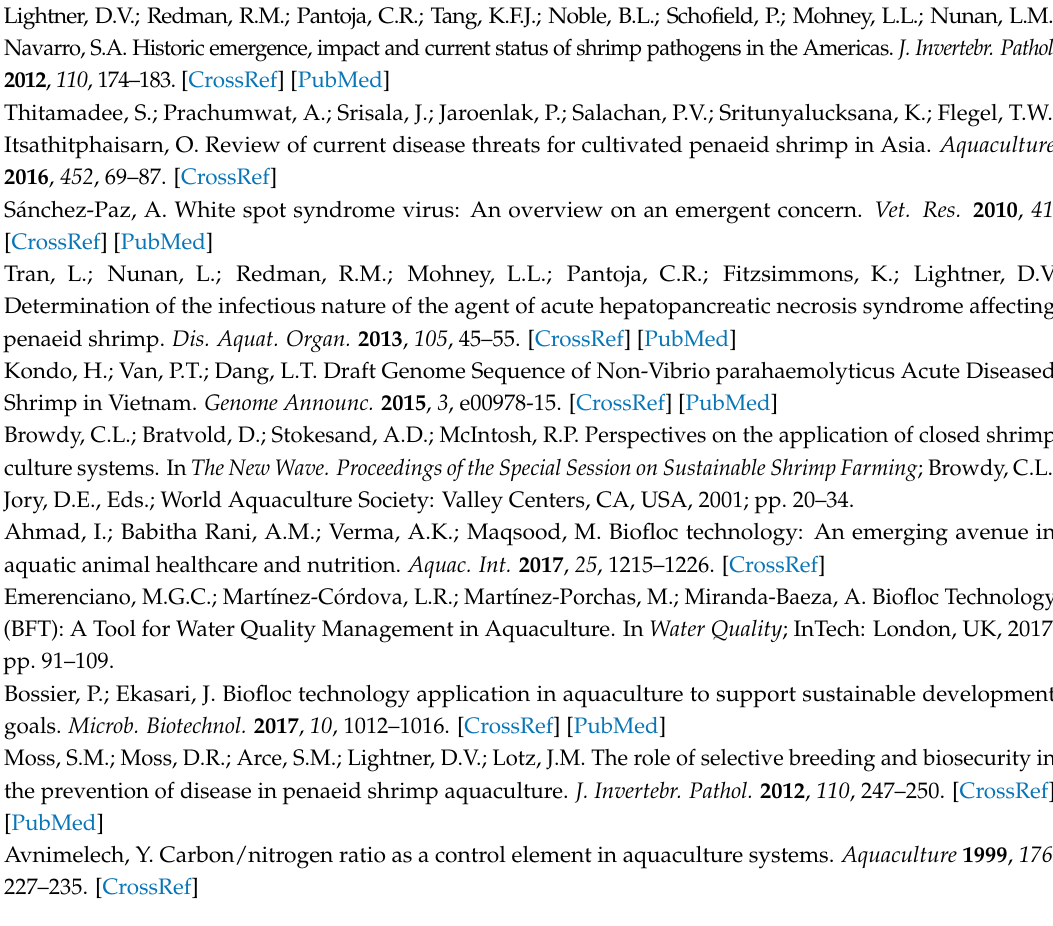
Table S1: Physicochemical parameters of the BFT water after four months of Litopenaeus vannamei rearing, Table S2: Overview of 16S-based Illumina Hi-Seq 2500 sequencing of Litopenaeus vannamei midgut reared in bioflocs (BFT) and clear seawater (CWS) and challenged with WSSV (BFT.W and CWS.W), Table S3: Shared and unique OTUs annotation from Litopenaeus vannamei midgut reared in bioflocs (BFT) and clear seawater (CWS) and challenged with WSSV (BFT.W and CWS.W), and the abundance of unique OTUs annotation from major bacterial phyla. Author Contributions: Experimental Design M.R.P., E.B., R.D.R. and L.M.P.; Shrimp rearing F.N.V. and